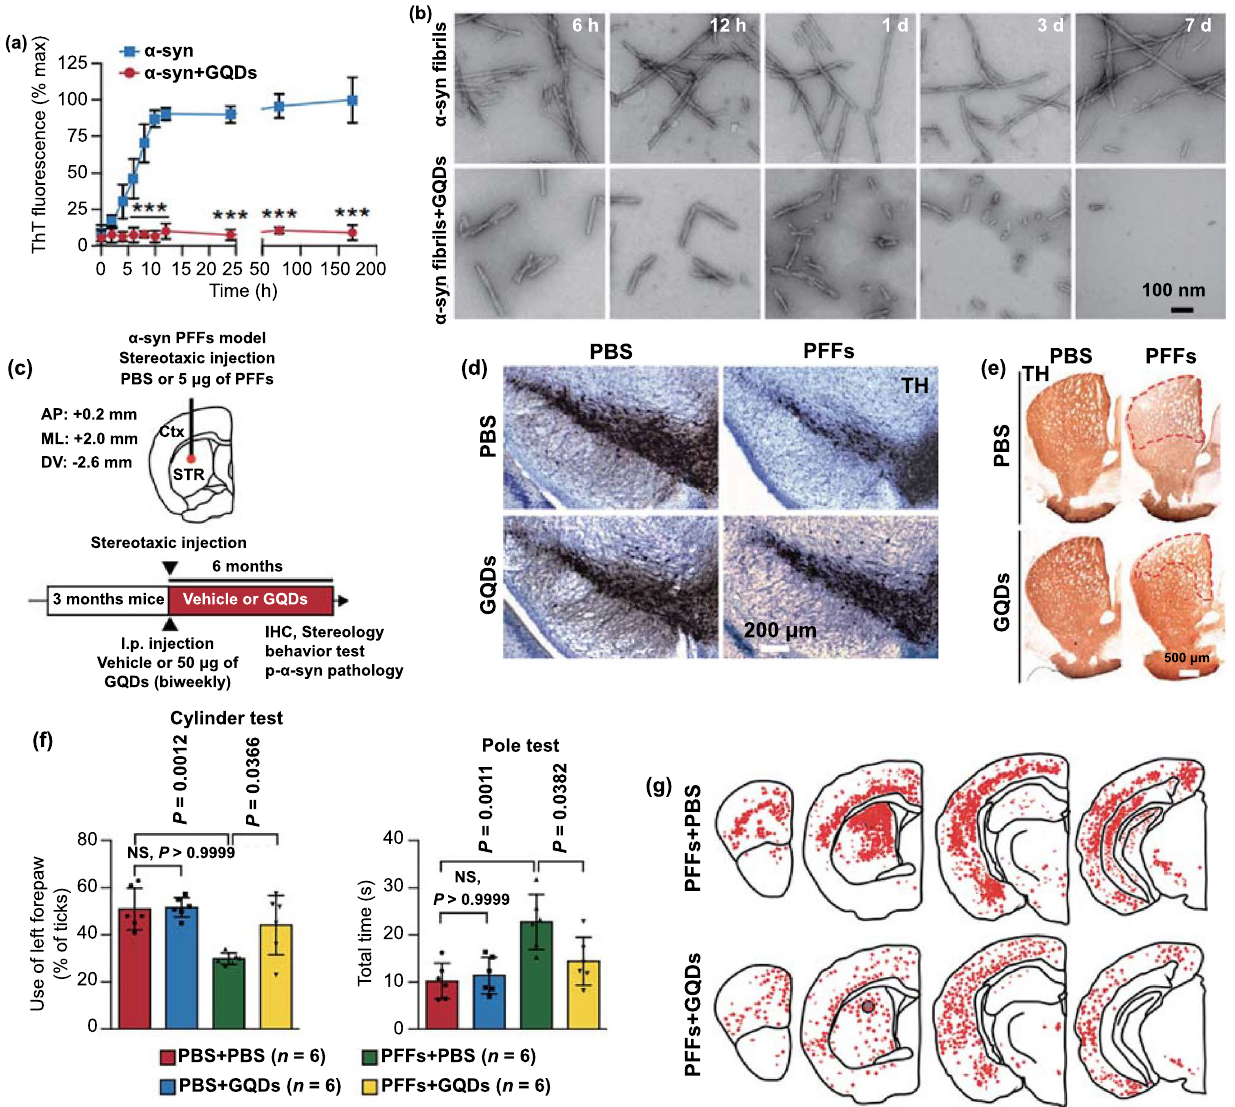
Fig. 11 Example of nano-bio effects resulting in the inhibition of α-syn. a Kinetics of α-syn fibrillization monitored using a ThT fluorescence assay. b TEM images of preformed α-syn fibrils at various time points (6 and 12 h and 1, 3, and 7 days) in the absence (top) and presence (bot- tom) of GQDs. c Schematic illustration of stereotaxic intrastriatal injection coordinates for α-syn PFFs (5 μg) in C57BL/6 mice. As a treatment, 50 μg of GQDs or PBS were i.p. injected biweekly for 6 months. AP, anteroposterior; ML, mediolateral; DV, dorsoventral; Ctx, cortex; STR, striatum; IHC, immunohistochemistry. d Representative TH immunohistochemistry images of the SN from the α-syn PFF-injected hemisphere in the absence (top) and presence (bottom) of GQDs. e Representative TH immunohistochemistry images of the striatum from the α-syn PFF- injected hemisphere. f Assessments of behavioral deficits based on forepaw activity in the cylinder test (left) and the ability to grasp and descend from a pole (right). g Distribution of LB/LN-like pathology in the CNS of α-syn PFF-injected mice (p-α-syn positive neurons, red dots; p-α-syn positive neurites, red lines). Adapted with permission from Ref. [190]. Copyright 2018 Nature Publishing